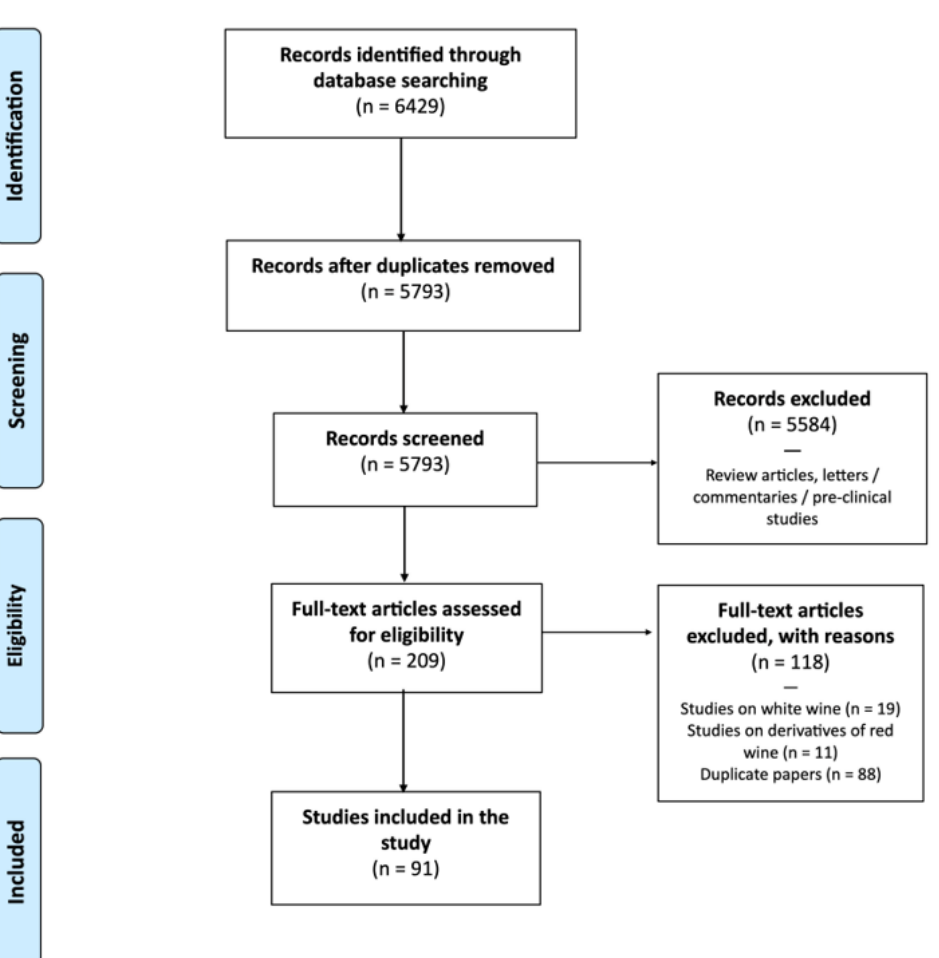
Figure 1. Flow chart of studies included.